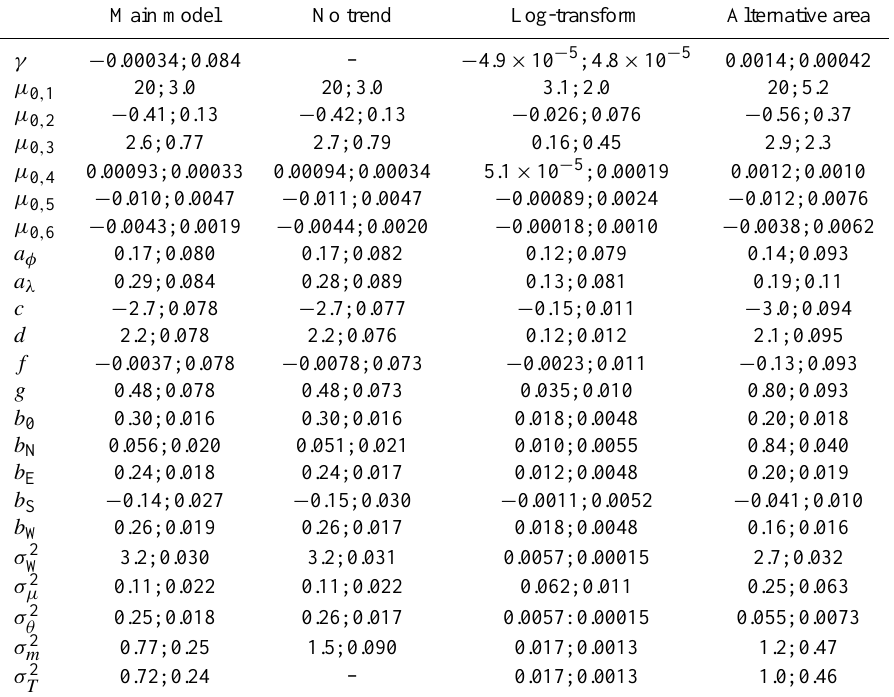
Table A1. Posterior marginal distributions (mean; standard